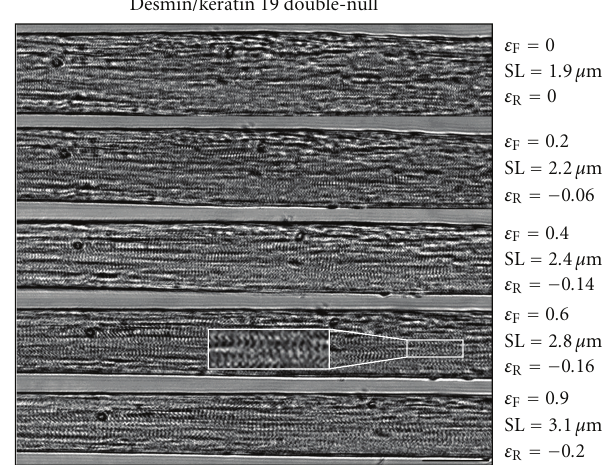
Figure 7: Geometric and structural response of a 10-month- old double-null fiber to tensile loading. The same region of the fiber, imaged using phase-contrast microscopy, is shown at five di ff erent deformations. Fiber strains, radial strains, and sarcomere lengths are reported to the right of the fiber for each deformation. Fiber displays both misaligned Z-lines as well as discontinuity between fiber, sarcomere, and radial strains. A sample region of the fiber that displays the basketweave pattern characteristic of misalignment is marked with a white box. The boxed region has been also computationally enlarged 2x for clarity. As for desmin- null fibers, double-null fibers display dramatically more debris on their external membrane compared to wild-type fibers. Bar = 50 μ